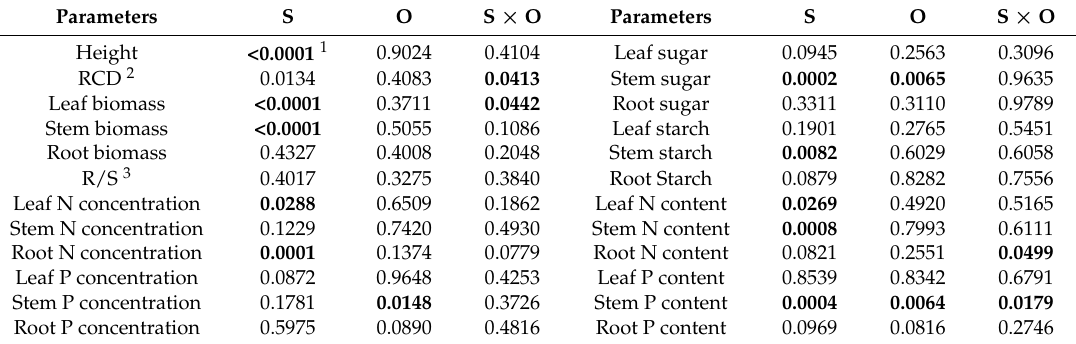
Table 1. p values from analysis of variance (ANOVA) analysis of lighting spectra (S), chitosan oligosaccharide addition (O), and their interaction (S × O) on parameters of Fragrant rosewood ( Dalbergia odorifera )